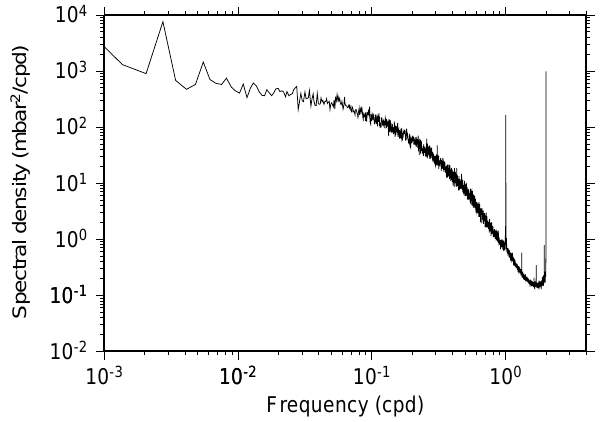
Fig. 13. Globally integrated spectrum of the ECMWF p a series, based on the four-year span 1996–1999. For computational details, see Wunsch and Stammer (1995).